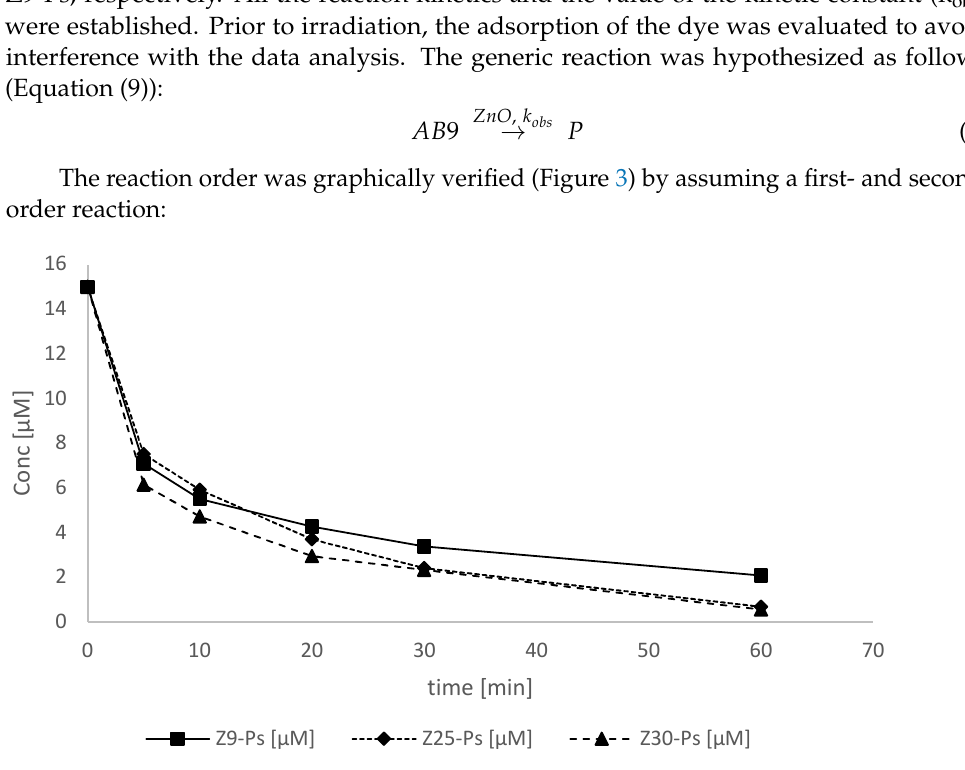
Figure 3. Trend of the concentration of dye over time following irradiation with UV radiation. ZnO-induced photocatalysis of different particle sizes.